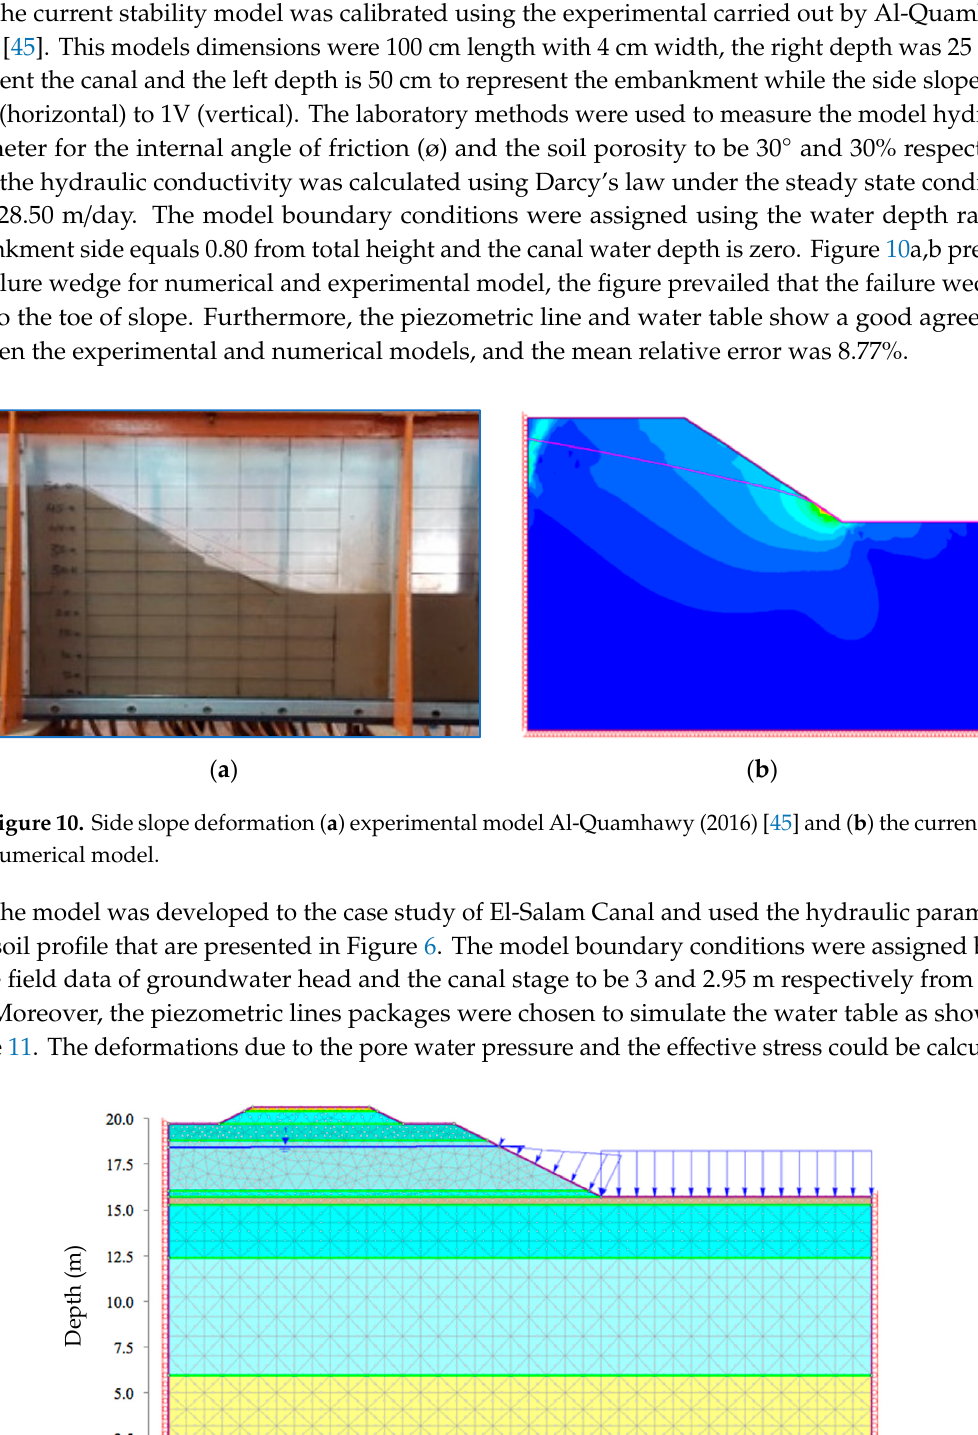
Figure 9. Arial view of groundwater level in study area at sea level rise (SLR) by ( a ) 26.70 and ( b ) 51.30 cm.